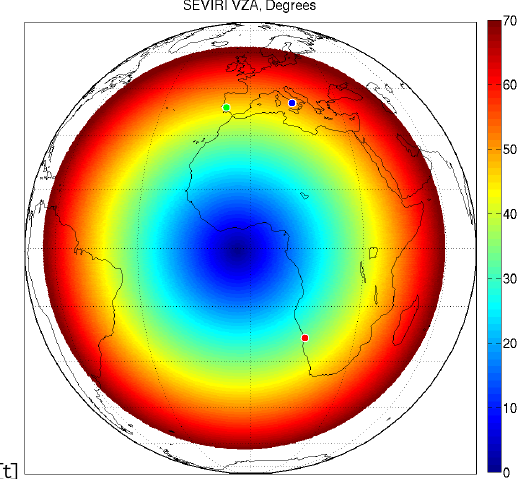
Figure 1. SEVIRI full disk according to the rule VZA (viewing zenith angle) ≤ 70 ◦ . The two dots over land give the location of KIT validation stations. The dot over the Mediterranean sea is the loca- tion of the SEVIRI pixel used to compare the retrieved T s against AVHRR data.